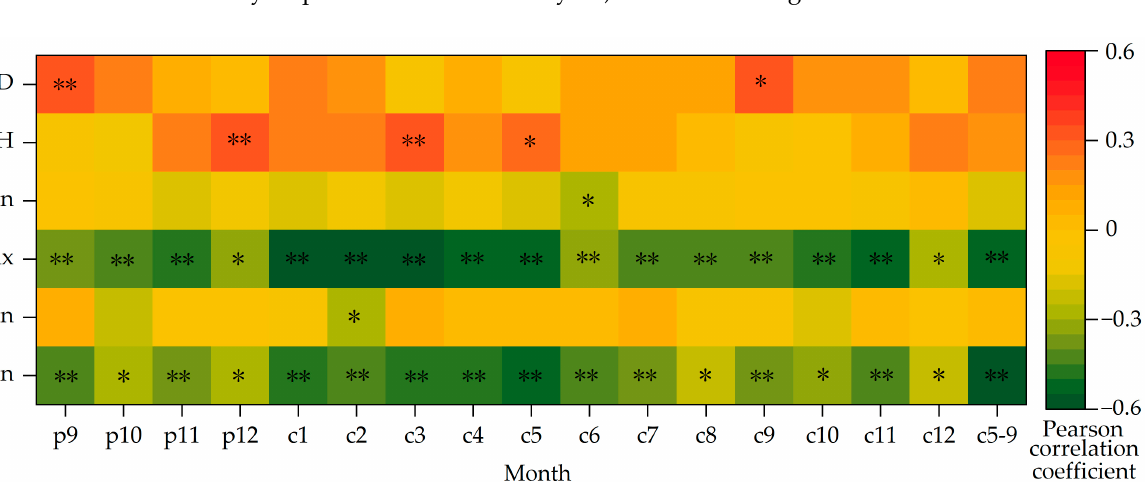
Table 1. The relationship between δ 13 C and WUE of Picea meyeri and annual meteorological factor on Luya mountain.